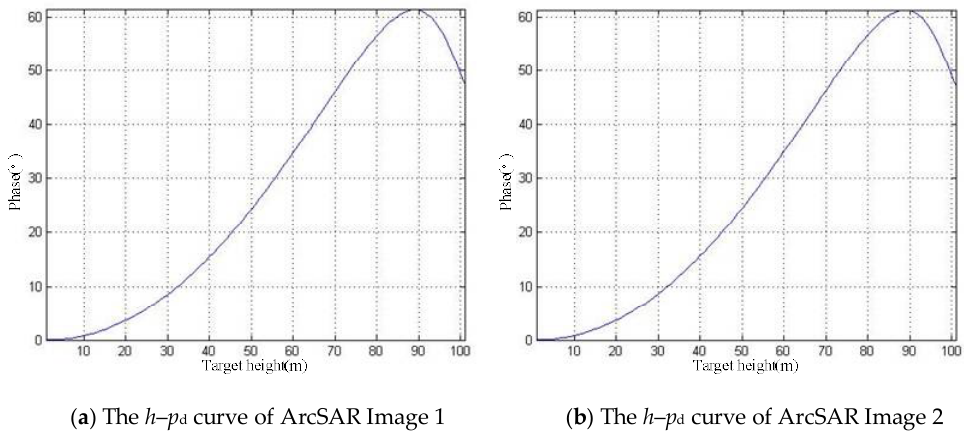
Figure 14. The h – p d curves.